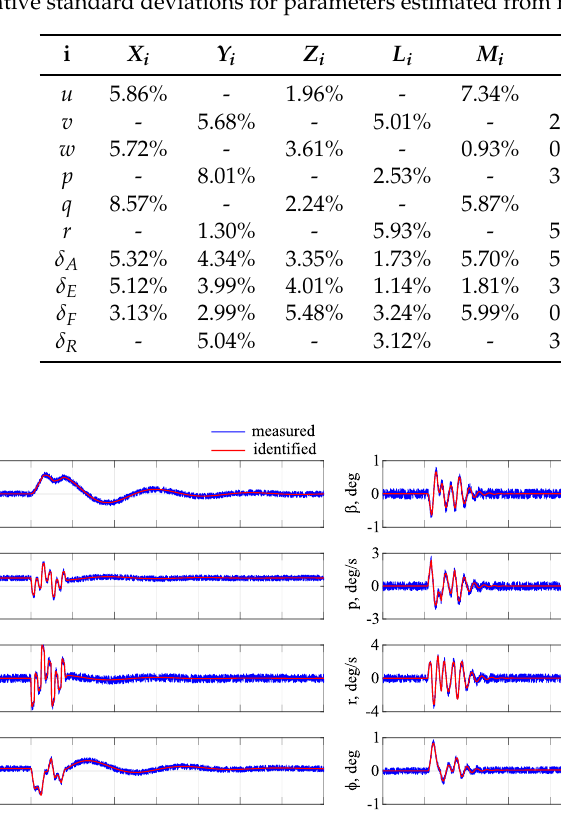
Table 4. Relative standard deviations for parameters estimated from multi-step experiments.